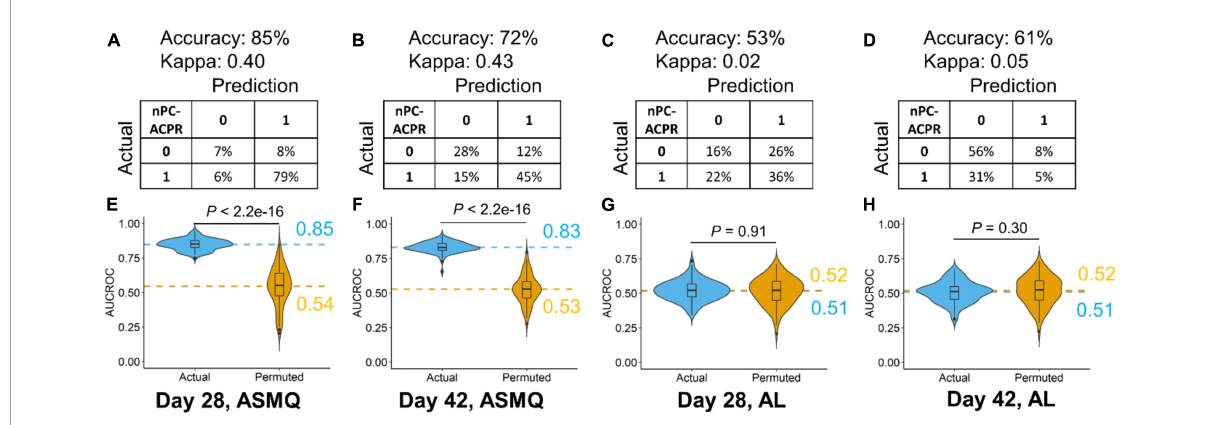
FIGURE5 Performance evaluation of random forest models predicting ASMQ outcomes on day 28 and 42 (A–D) . Prediction accuracy, kappa, and confusion matrices. The rows of confusion matrices represent the actual treatment outcomes, whereas the columns indicate the predicted treatment outcomes (E–H) . Comparison of AUCROC values from 100 repetitions of 100 times repeated fivefold cross-validation using actual (blue) vs. permutated (yellow) nPC-ACPR labels. Dashed line represented the mean AUCROC values. Significance is determined using Mann-Whitney-Wilcoxon test.